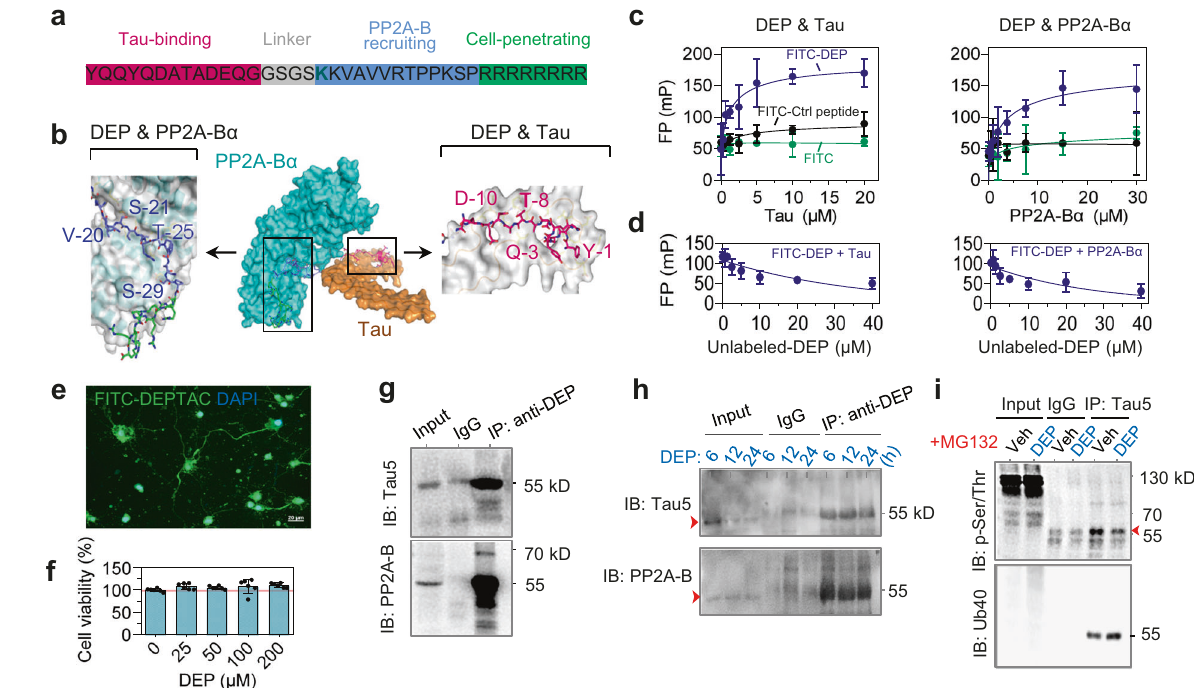
Fig. 1 DEPTAC binds to tau and simultaneously recruits PP2A-B α . a Functional motifs and amino acid sequence of DEPTAC (DEP). b The estimated triadic interaction of DEPTAC with tau (khaki) and PP2A-B α (cyan) based on their 3D-structures in ZDOCK Server. Key binding residues of DEPTAC were as labeled. c , d Direct interactions of FITC-conjugated DEPTAC to tau and PP2A-B α measured by fl uorescence polarization binding ( c ) and the competing ( d ) assays. e High cell penetrability of DEPTAC in cultured primary rat neurons. Scale bar, 20 μ m. f No cytotoxicity of the DEPTAC (to 200 μ M) detected by CCK8 assay. Data were normalized by the mean value of the 0- μ M group. One-way ANOVA followed by Tukey ’ s multiple comparisons tests. F (4, 25) = 1.47, P = 0.24. g The triadic interaction of DEPTAC with tau and PP2A-B was con fi rmed by immunoprecipitation using DEPTAC antibody in primary cultured rat neurons (12 h). h Co-immunoprecipitation of DEPTAC with tau and PP2A-B can be detected 6 – 24 h of post-DEPTAC treatment, with a gradual decrease of total tau. i DEPTAC decreased tau phosphorylation at Ser/Thr residues with upregulated tau ubiquitination in the presence of